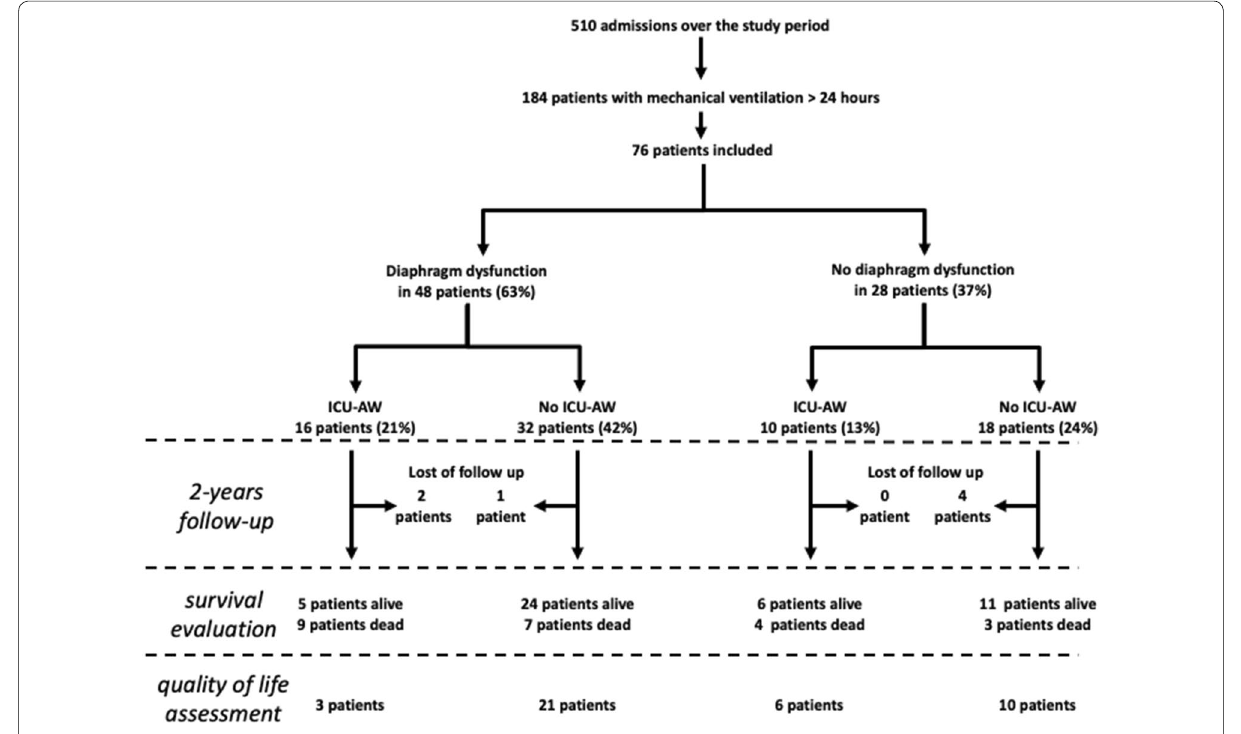
Fig. 1 Study flowchart. ICU-AW intensive care unit‑acquired